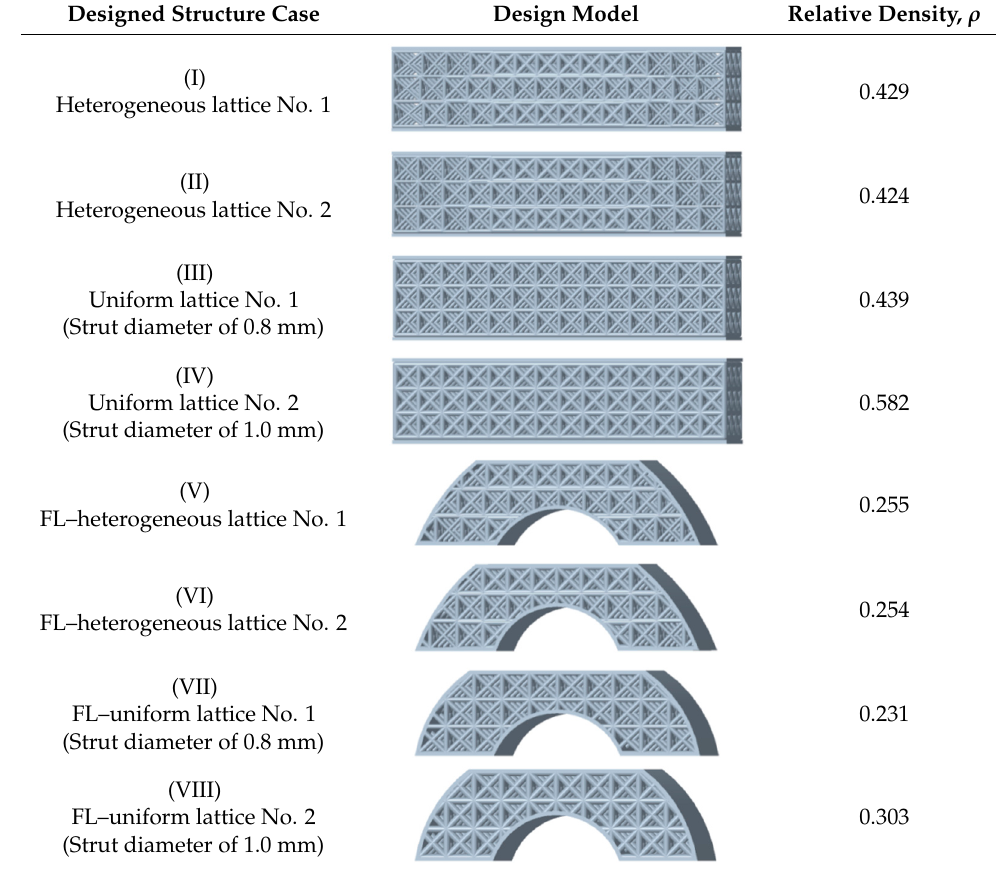
Figure 6. The schematic of the generation process of topology-optimized lattice structures for further weight reduction under the load-bearing orientation and stress distribution. Table 1. Information on the designed lattice structures.